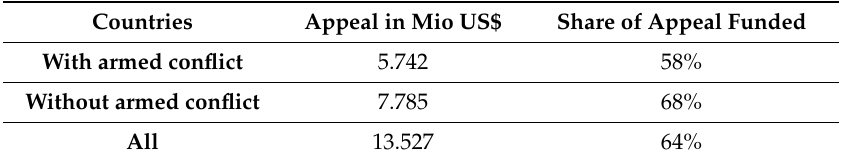
Table 4. UN emergency assistance appeals and funding, countries with and without armed conflict,